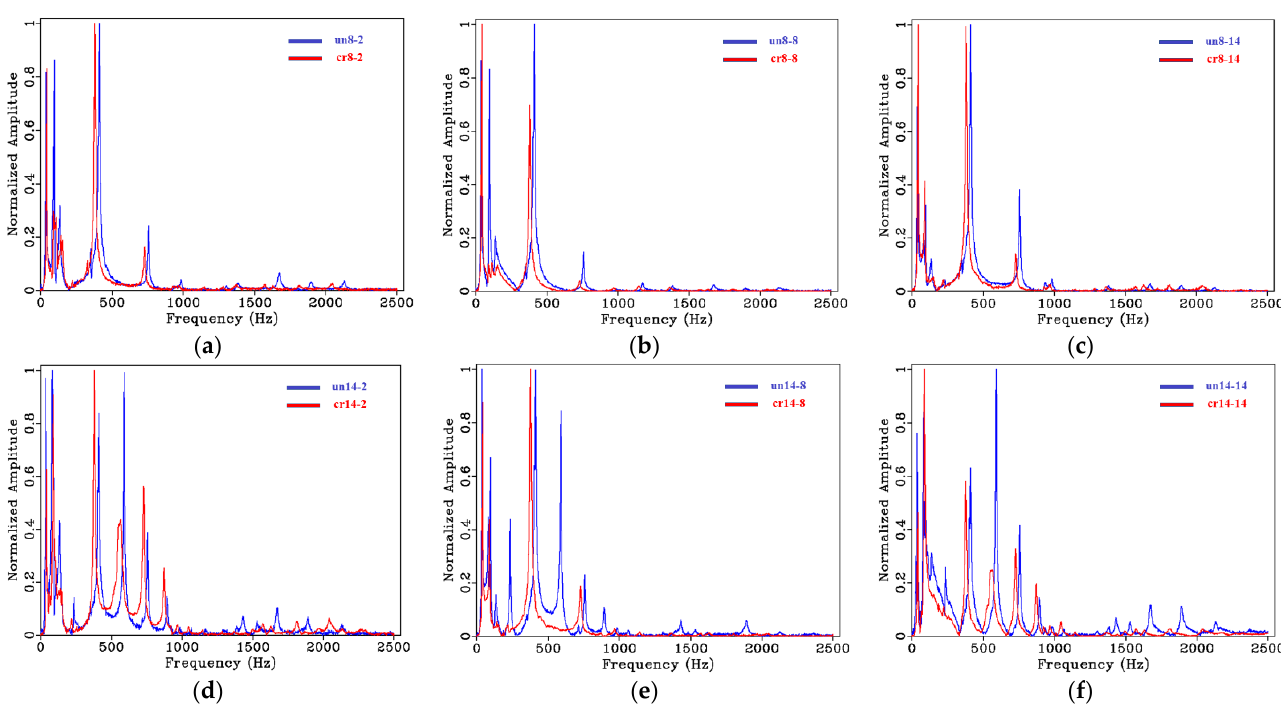
Figure 14. Normalized pre-damage and post-damage acceleration response signal spectra: ( a ) un8-2 and cr8-2; ( b ) un8-8 and cr8-8; ( c ) un8-14 and cr8-14; ( d ) un14-2 and cr14-2; ( e ) un14-8 and cr14-8; ( f ) un14-14 and cr14-14.